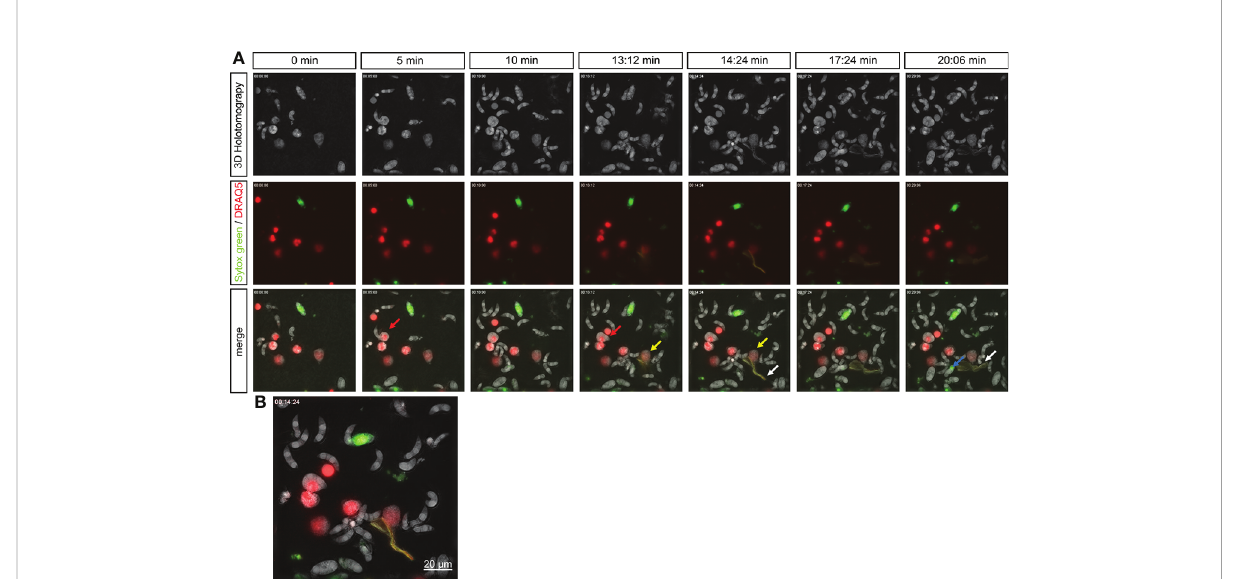
FIGURE 5 Live-cell imaging of vital NETosis performed by E. bovis -exposed PMN. Time lapse of a holotomographic video generated by 3D Cell Explorer (Nanolive) on the interaction between bovine PMN and live E. bovis sporozoites. The interactions between PMN and sporozoites were monitored for a total 100 min. The complete video of the interaction is available in the supplementary material. Panel (A) shows the 3D holotomography, green – red channels, and the merge. The nuclei of PMN were stained with DRAQ5 (red), extracellular DNA (as a marker of NETosis) with SYTOX green. Red arrow: PMN being invaded by a E. bovis sporozoite. Yellow arrow: PMN releasing NETs. White arrows: NET structure. Blue arrow: dead sporozoite. Numbers indicate the time points of interaction between PMN and E. bovis sporozoites. (B) shows a merge of all channels at 14 min of interaction and illustrates the formation of NETs and the contact of this DNA structure with a E. bovis